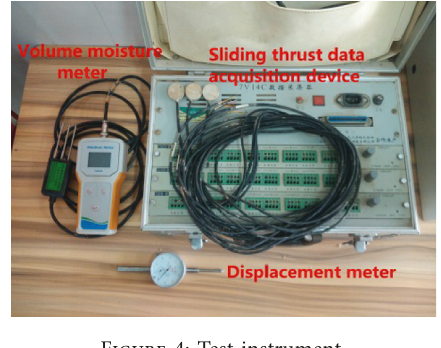
Figure 4: Test instrument.